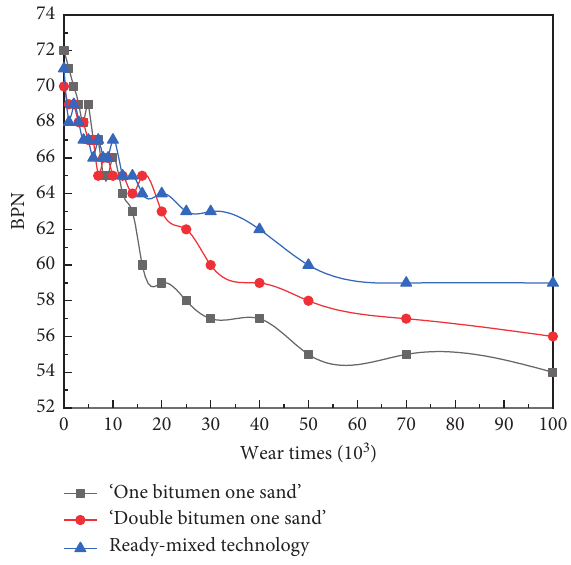
Figure 20: BPN wear law of different processes.